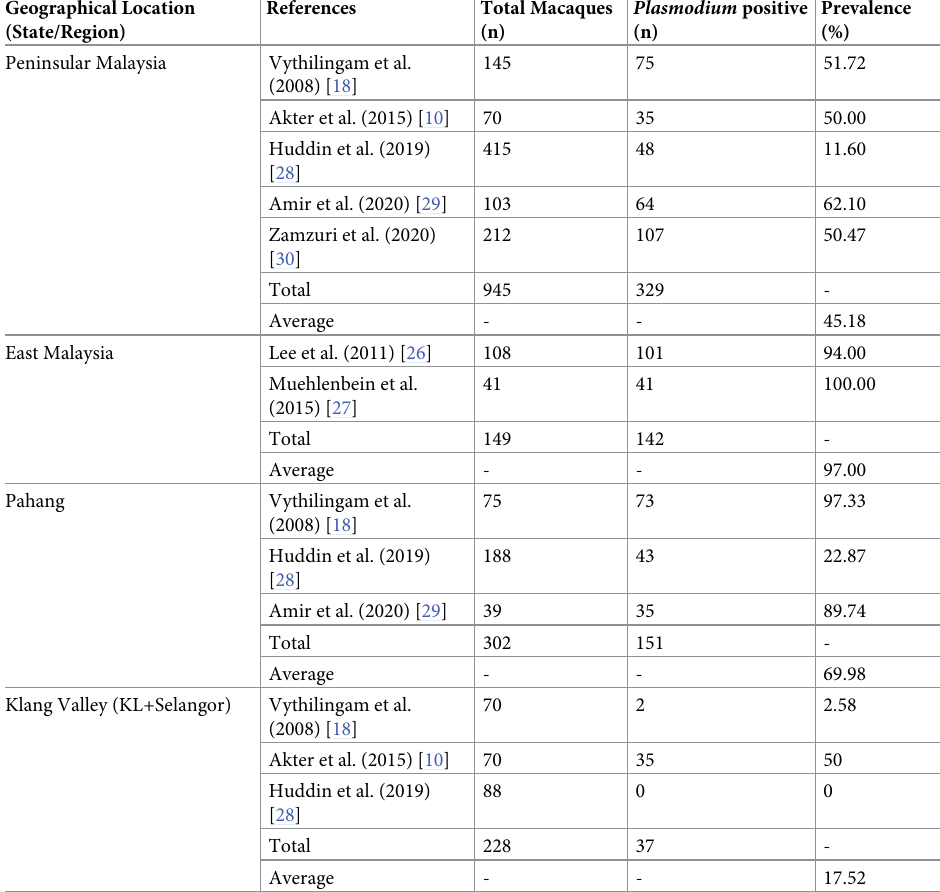
Table 5. The prevalence of Plasmodium positive macaques in comparison of geographical location and regions. Geographical Location